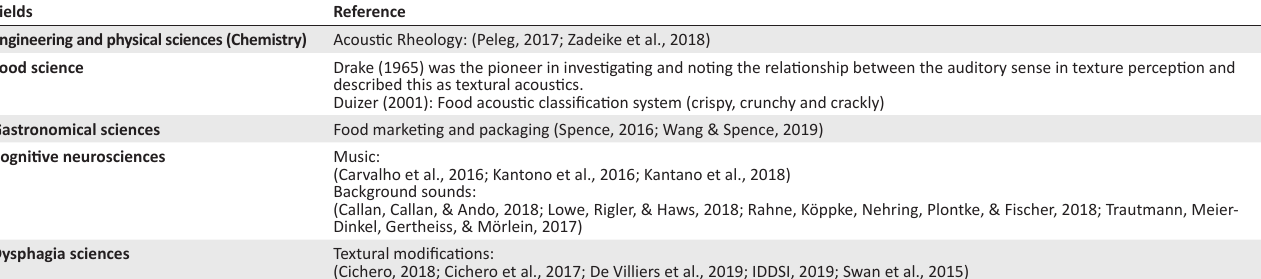
TABLE 1-A1: Established fields that have alluded to food textural acoustics. Fields